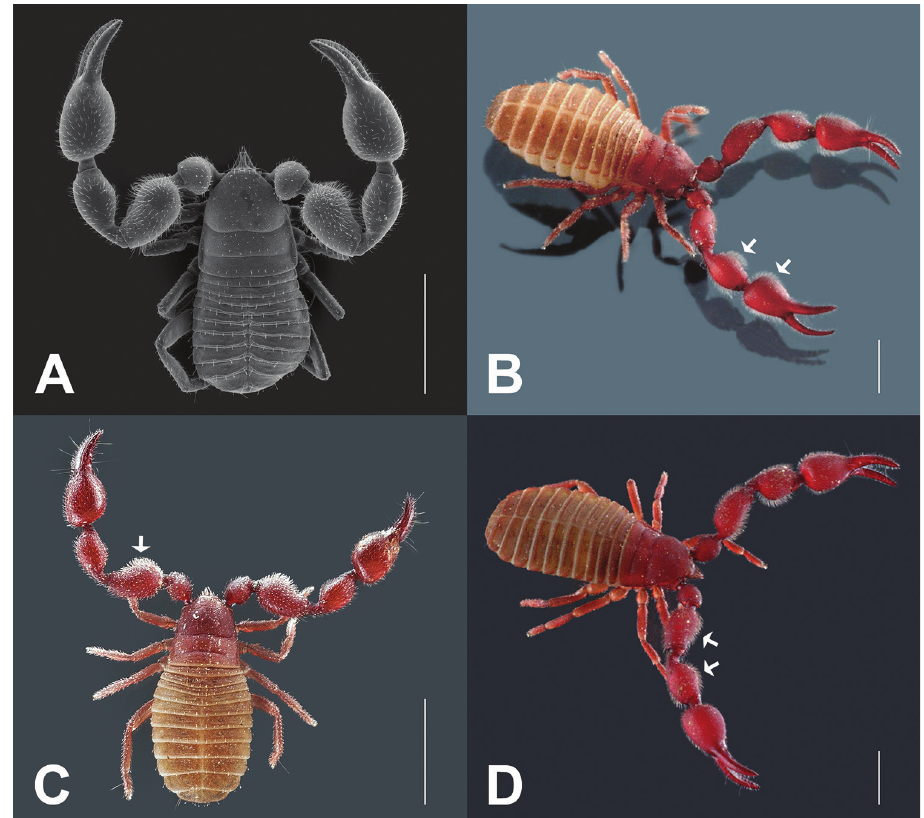
Figure 2. Males of Lasiochernes species. A L . jonicus (scanning electron micrograph) B L . cretonatus C L . jonicus D L . pilosus . Arrows point to long, dense setation on palps. Scales lines: 1